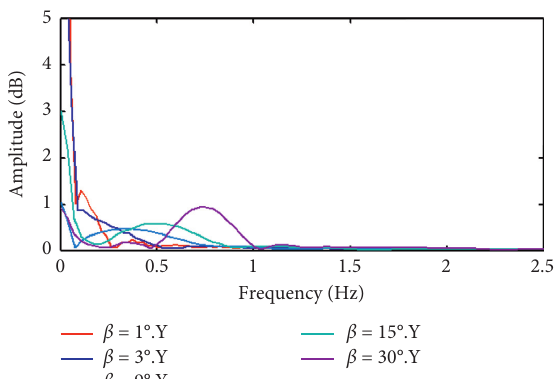
Figure 12: The frequency domain response analysis of the centroid of the platform in Y direction when F different well inclination angles β .